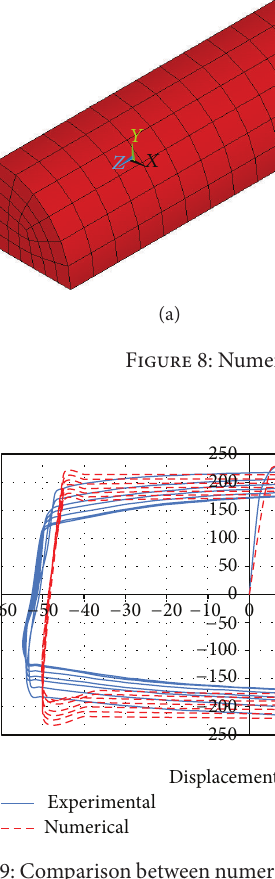
Figure 9: Comparison between numerical and experimental results (case B).